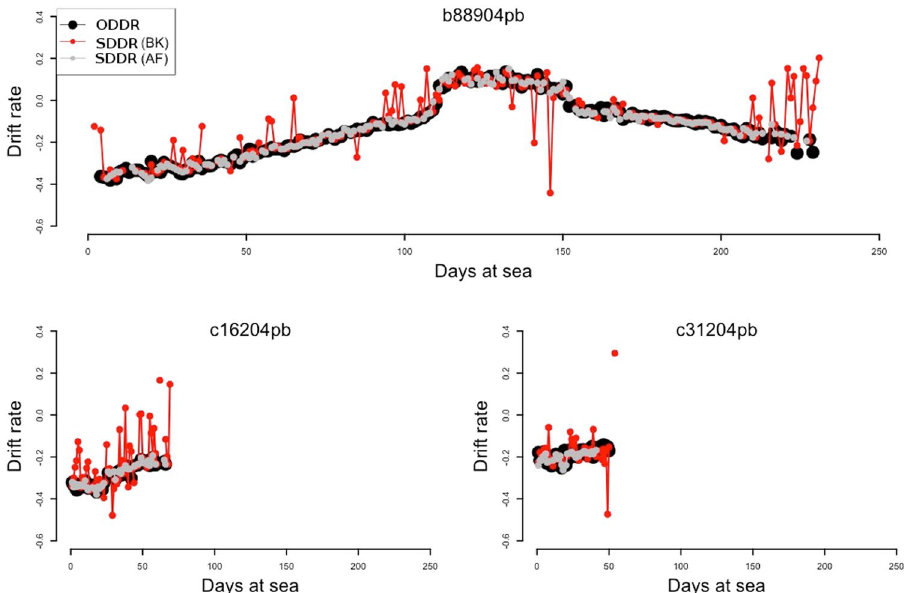
Figure 5. Kalman filter application. Comparison shows three daily averaged drift rate trajectories of the seals used to develop this method (b88904pb, c16204pb and c31204pb). ODDR refers to the observed daily averaged drift rate and SDDR to the daily averaged drift rate from summarized data both before (BK) and after (AK) applying the Kalman Filter. Lines between points join consecutive daily